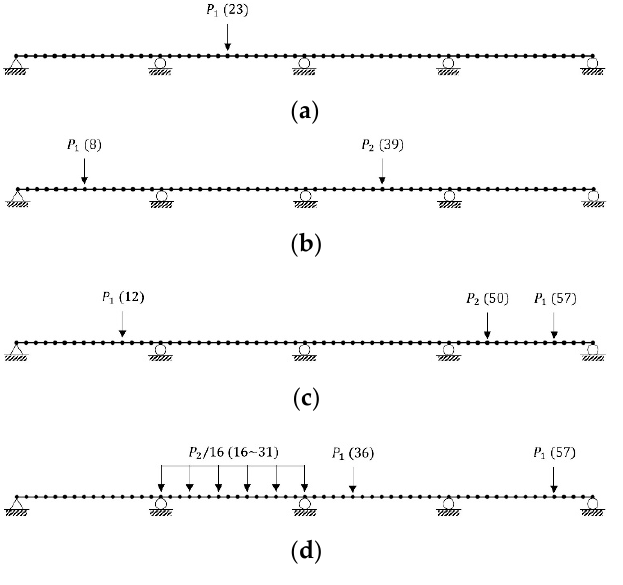
Figure 5. Load conditions for real deformed shape assumed by FEM model (beam): ( a ) RDS1, ( b ) RDS2, ( c ) RDS3, ( d ) RDS4.